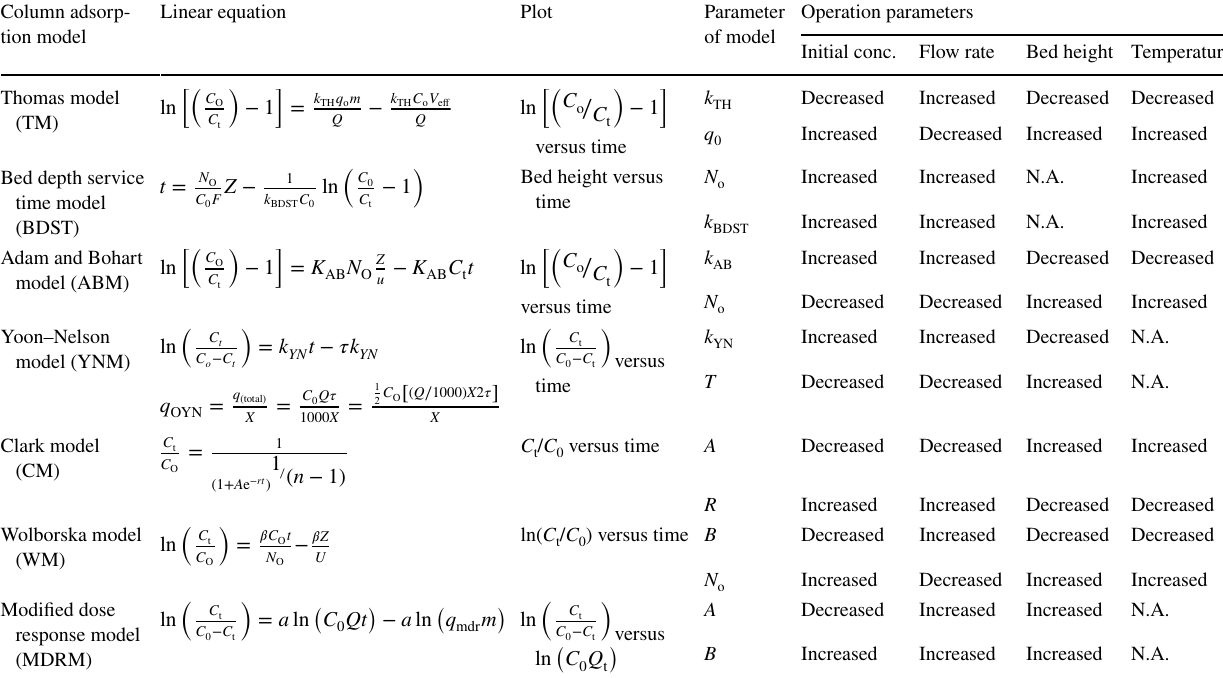
Table 3 Details of column adsorption models and its parameters variation in column adsorption model w.r.t. increasing operation parameters (Lee et al. 2015; Biswas and Mishra